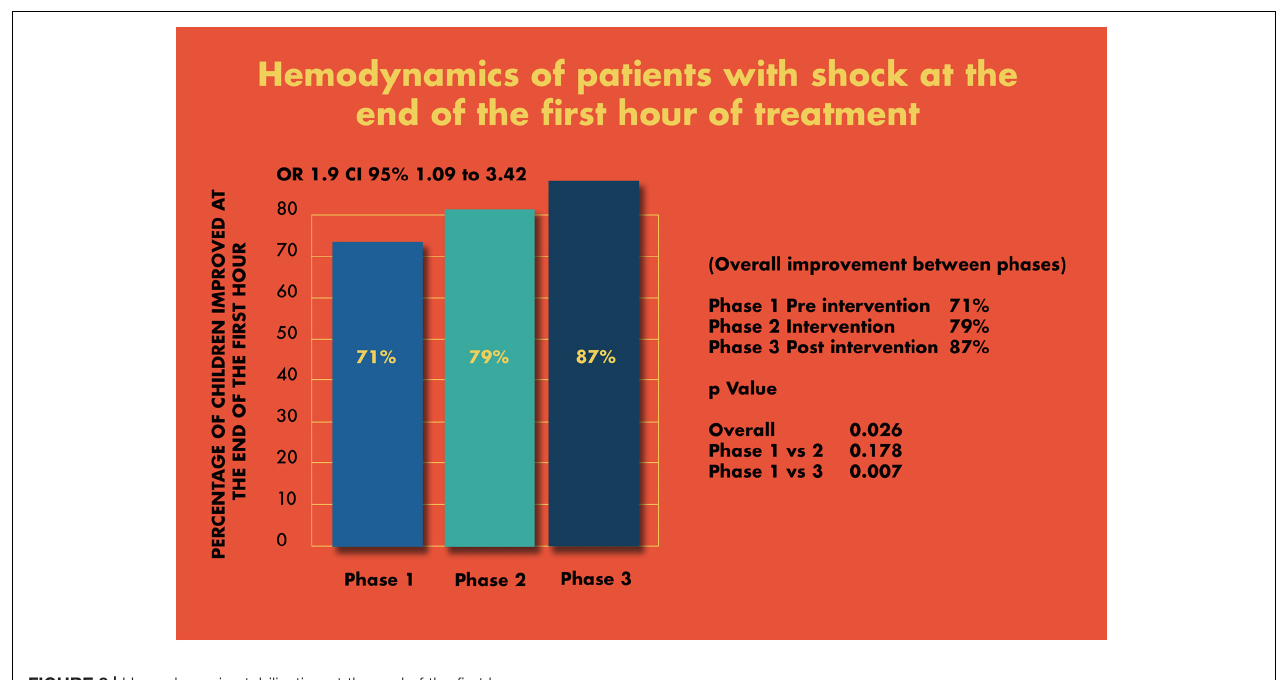
FIGURE 8 | Hemodynamic stabilization at the end of the first hour.